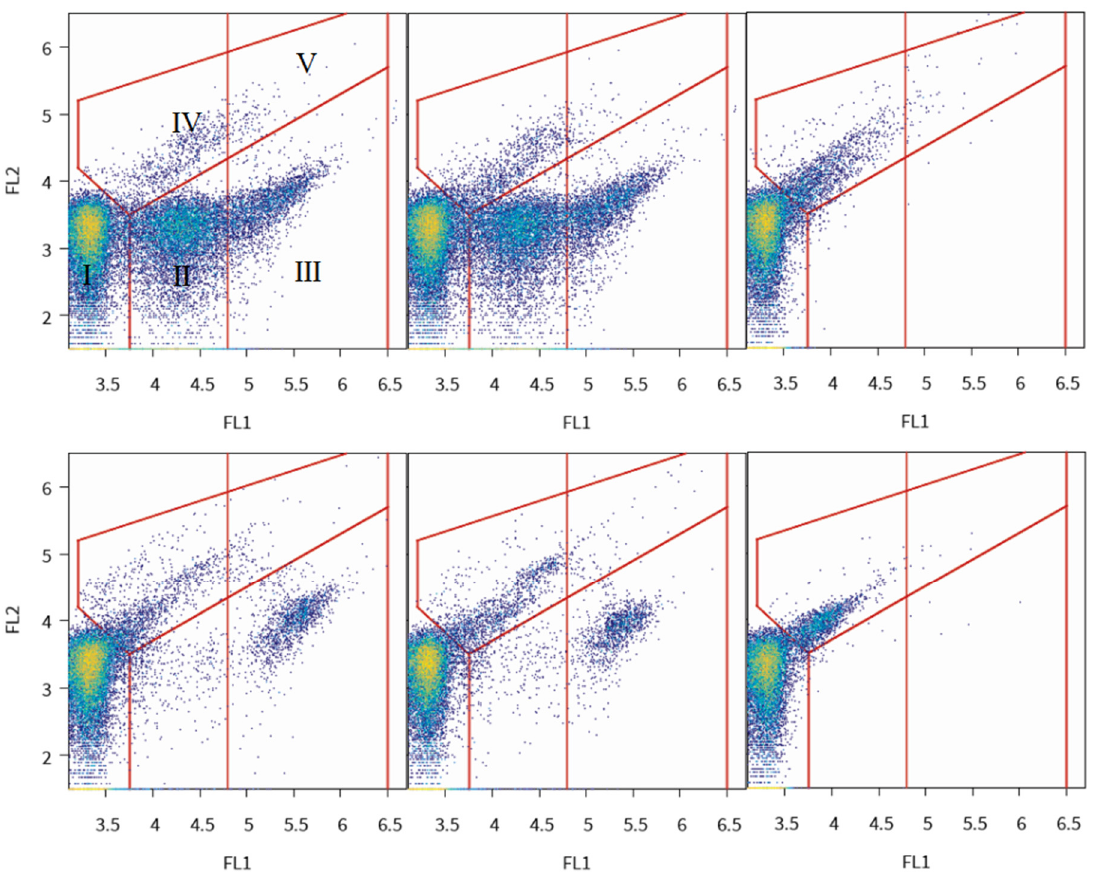
Figure 4. Dot-plots of water treatment trains in CI, Line 1: RBF, aeration, ozonation; Line 2: sandfilter, ultraviolet (UV-C) disinfection, assignments of Sections I to III: Background Signal, Intact LNAC, Intact HNAC, Sections IV-V: Lysed Cells, x-axis: Flourescence Signal 1 (FL1), y-axis: Flourescence Signal 2 (FL2).